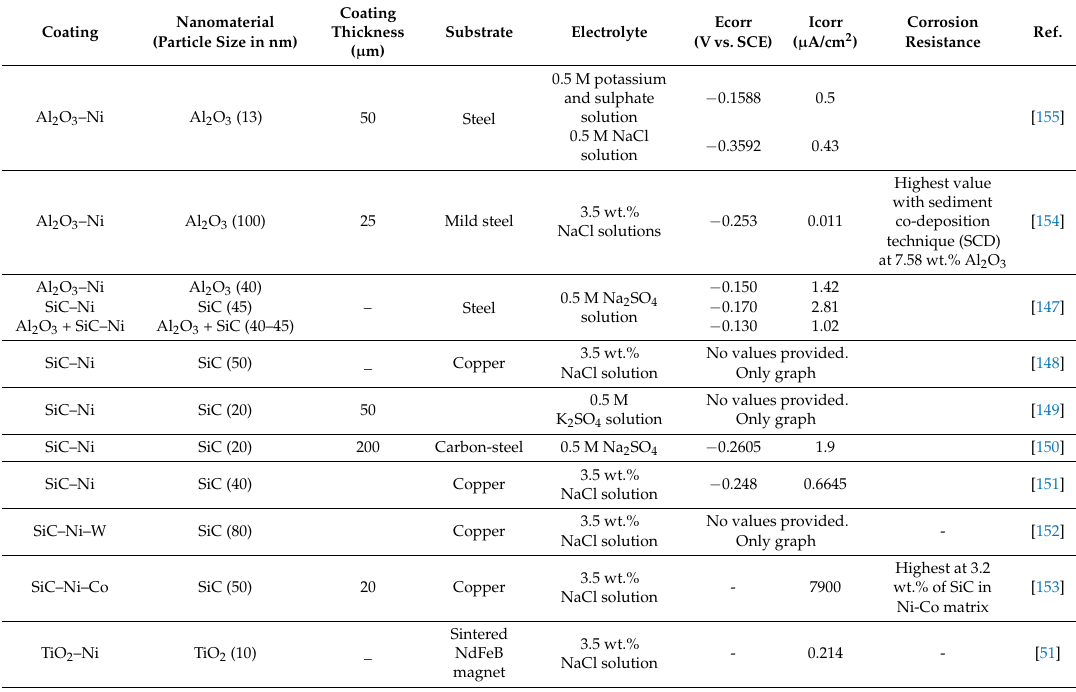
Table 4. Summary of some corrosion parameters for metallic host matrix nanocomposite coatings.